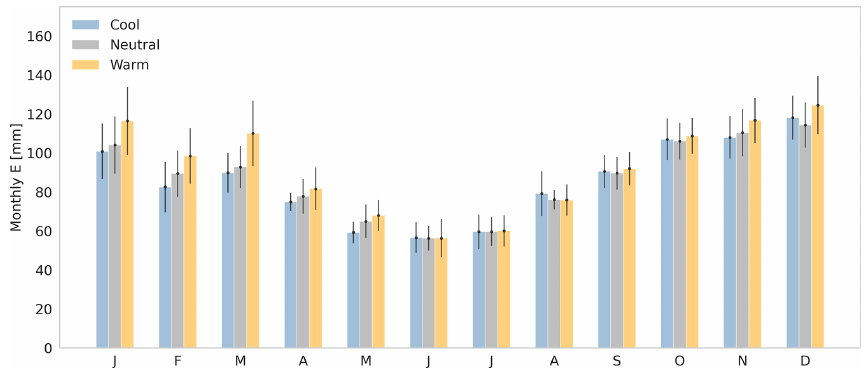
Figure 11. Interannual–seasonal variability of monthly evaporation in the period 1950–2020 separated by cool, neutral and warm ENSO phases. Error bars represent the standard deviation of every averaged